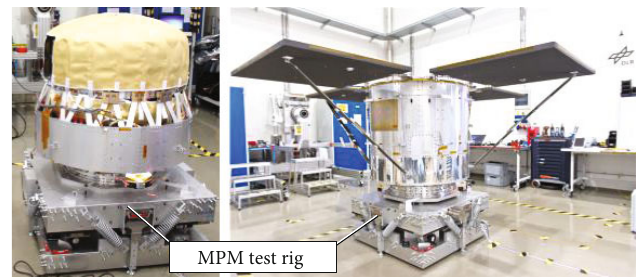
Figure 14: FM MPM test #1 and #2.